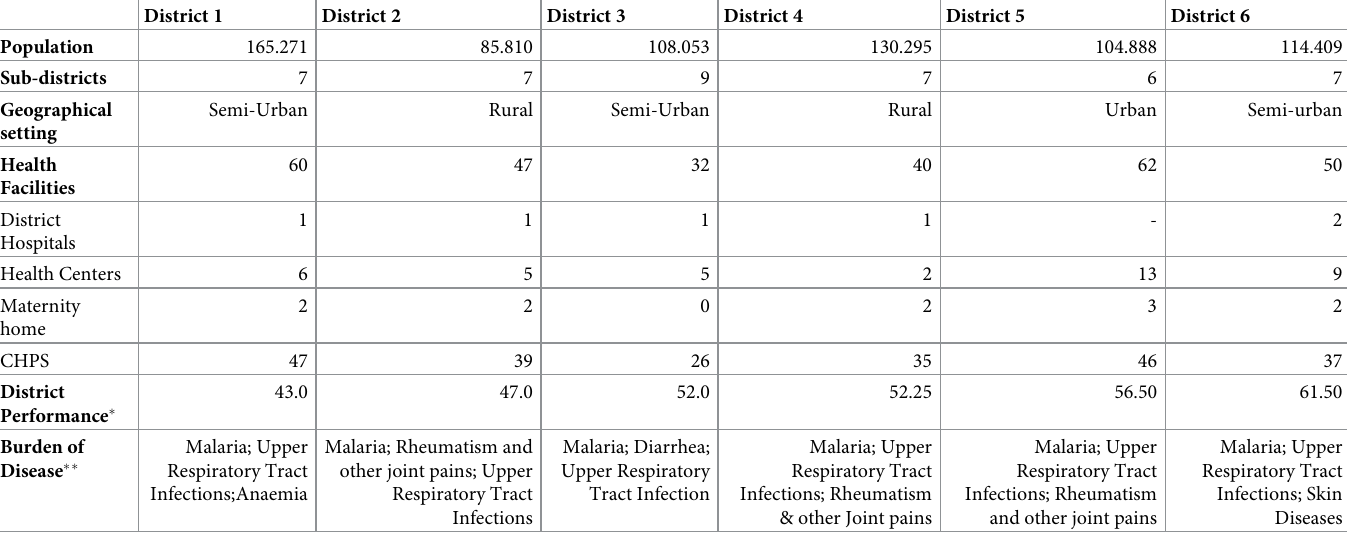
Table 1. Characteristics of the six study